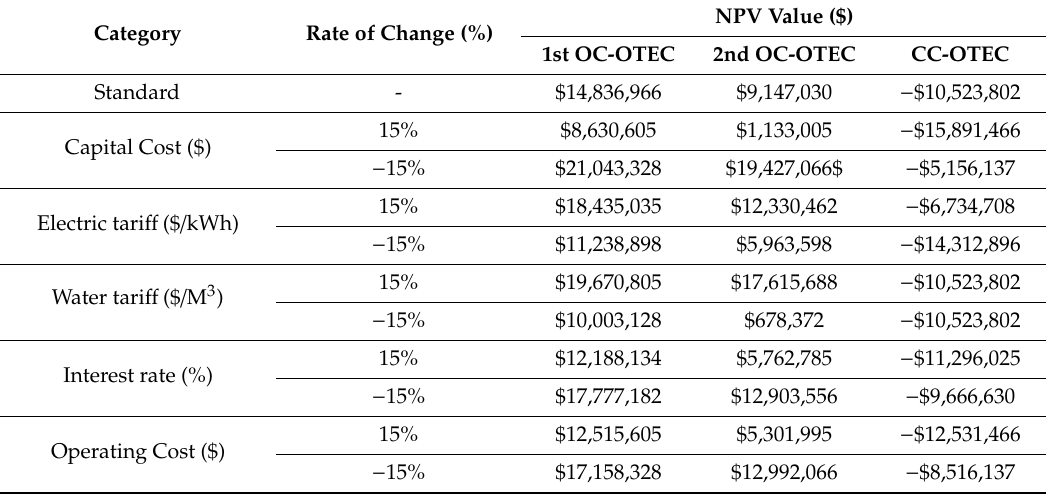
Table 7. Parameters of